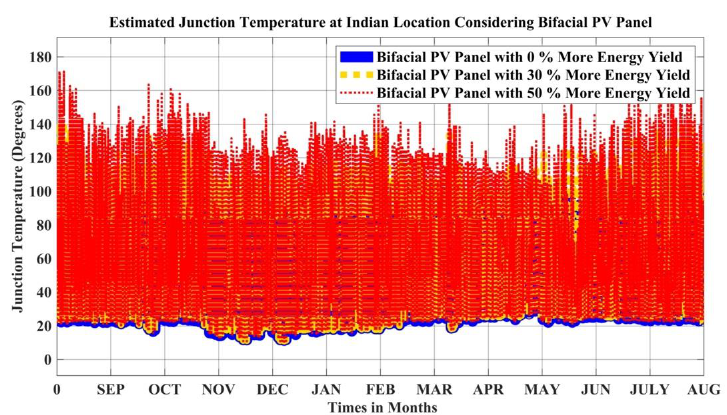
Figure 15. One-year estimated junction temperature at the location in India.